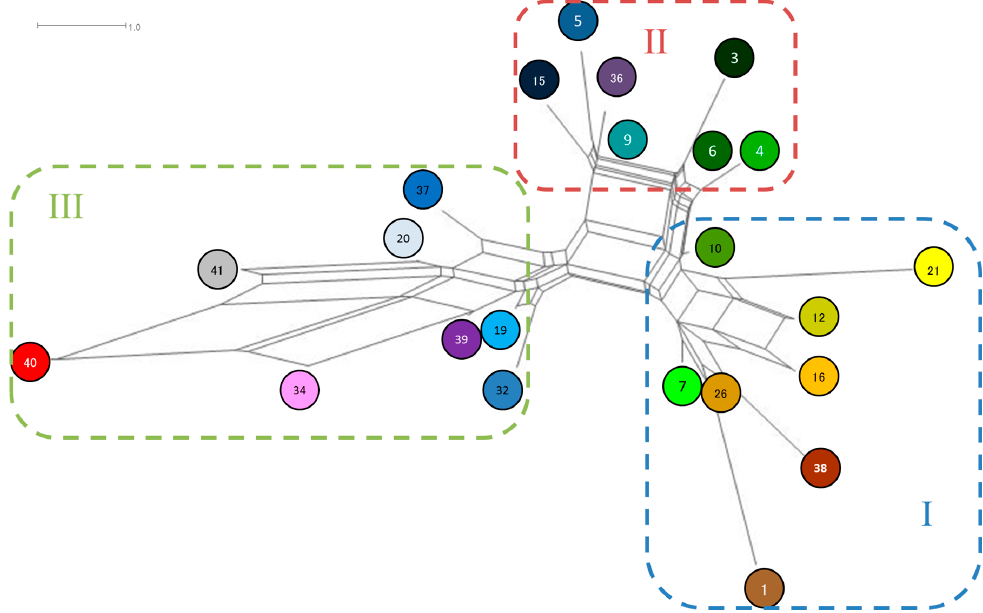
Figure 2. A Neighbor-net of 23 Chloroplast haplotypes for Quercus acutissima . Haplotypes of Group I were distributed mainly in Korea, haplotypes of Group II were in China and northern Korea and haplotypes of Group III were dominant in